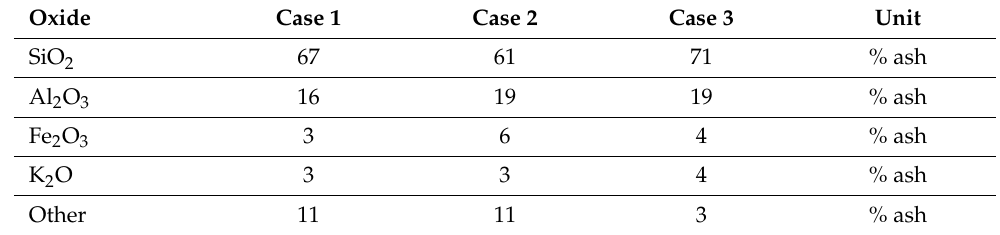
Table 16. Ash composition of biocoals (from cases 1–3).